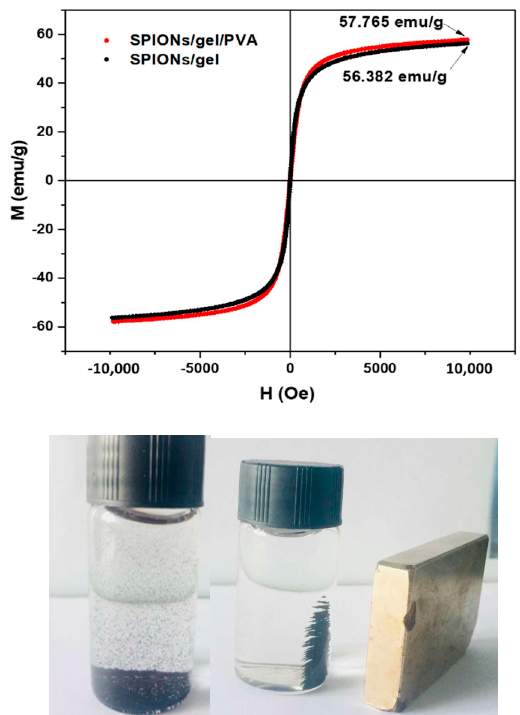
Figure 4. Magnetization curve of SPIONs/gel and SPIONs/gel/PVA; the magnetization responds to the external magnetic field of magnetic adsorbents.